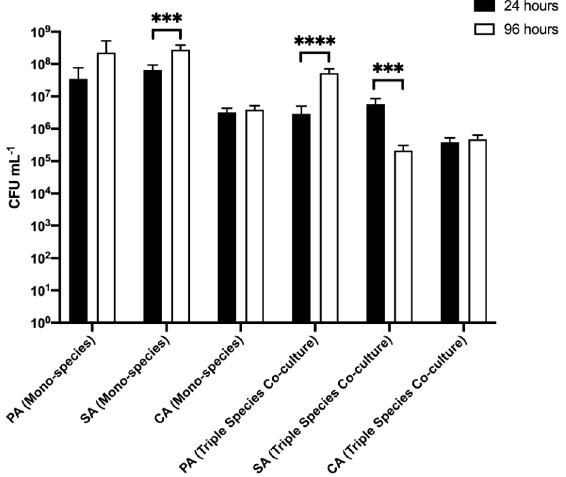
Figure 6. Cell titres derived from biofilms adhered to porcine bronchiole tissue. P. aeruginosa PAO1 (PA), S. aureus 25923 (SA) and C. albicans SC5314 (CA) cell counts (expressed as CFU mL (cid:3) 1 ) adhered to sections of ex vivo porcine lung tissue after incubation for 24 h (black bars) or 96 h (white bars) in the continuous-flow culture model. Asterisksindicatesignificant(*** P <0.001,**** P <0.0001)differencesinCFUmL (cid:3) 1 countsbetweenthe24hand96h time points. Data represent the mean (cid:4) standard deviation of three independent biological experiments in which three pieces of biofilm substratum were sampled per culture vessel per